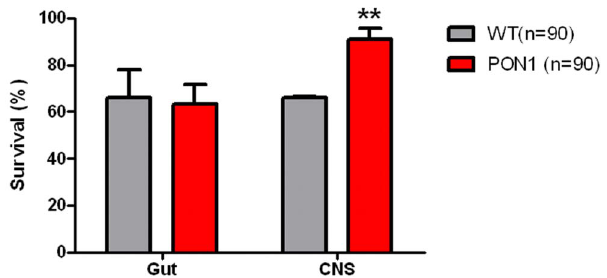
Figure 5. Survival of transgenic flies expressing PON with organ specific promoters. + /tub and PON transgenic flies with organ specific promoters were exposed to 3 hrs of anoxia and survival was recorded 24 hrs later. *p , 0.05, ** p , 0.01 when compared with +